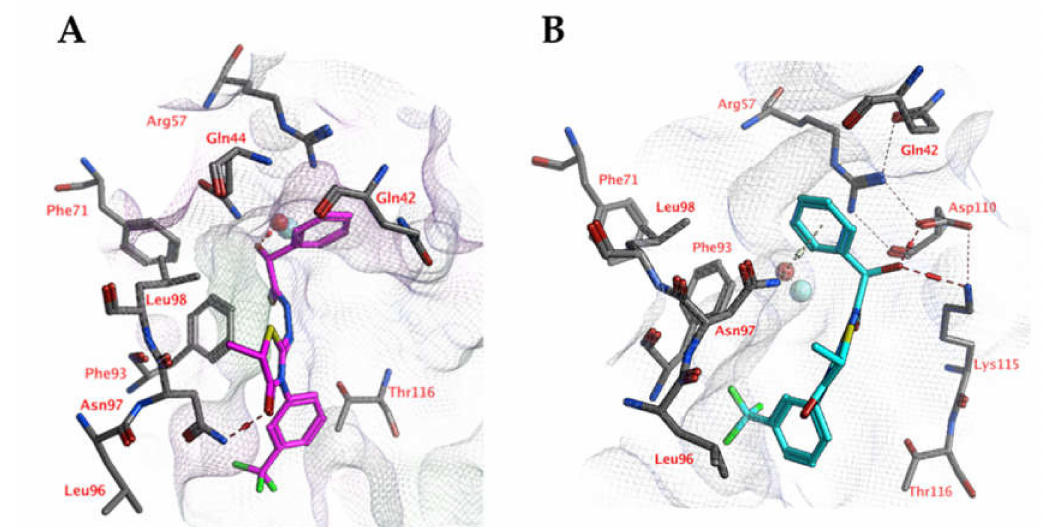
Figure 8. ( A ) The docked pose of compound 5k (purple) in the active site of CgNce103 (homology model). ( B ) The docked pose of compound 5k (turquoise) after a 5-ns molecular dynamics simulation. The pocket surface is indicated with a white mesh. hydrogen bonds are indicated in red dashed lines. The zinc ion is indicated in a turquoise sphere. The water molecule is indicated in a red sphere.